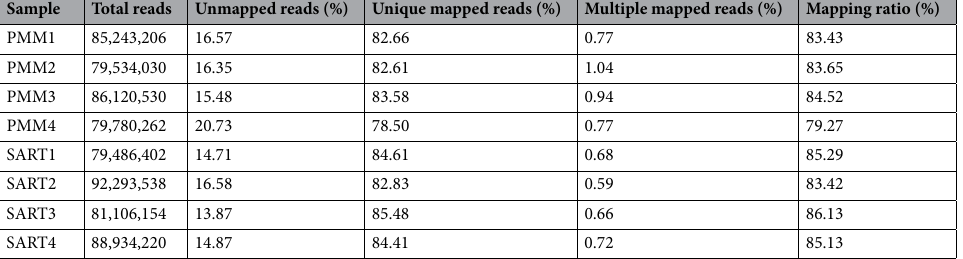
Table 2. The results of mapped reads.